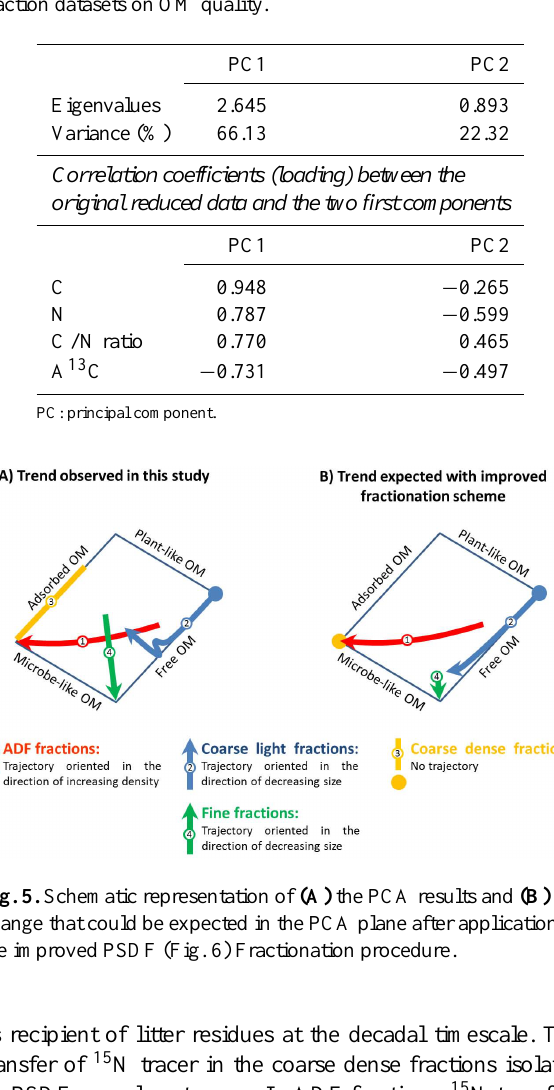
Table 4. Eigenvalues and percentage of explained variance for the fraction datasets on OM quality.